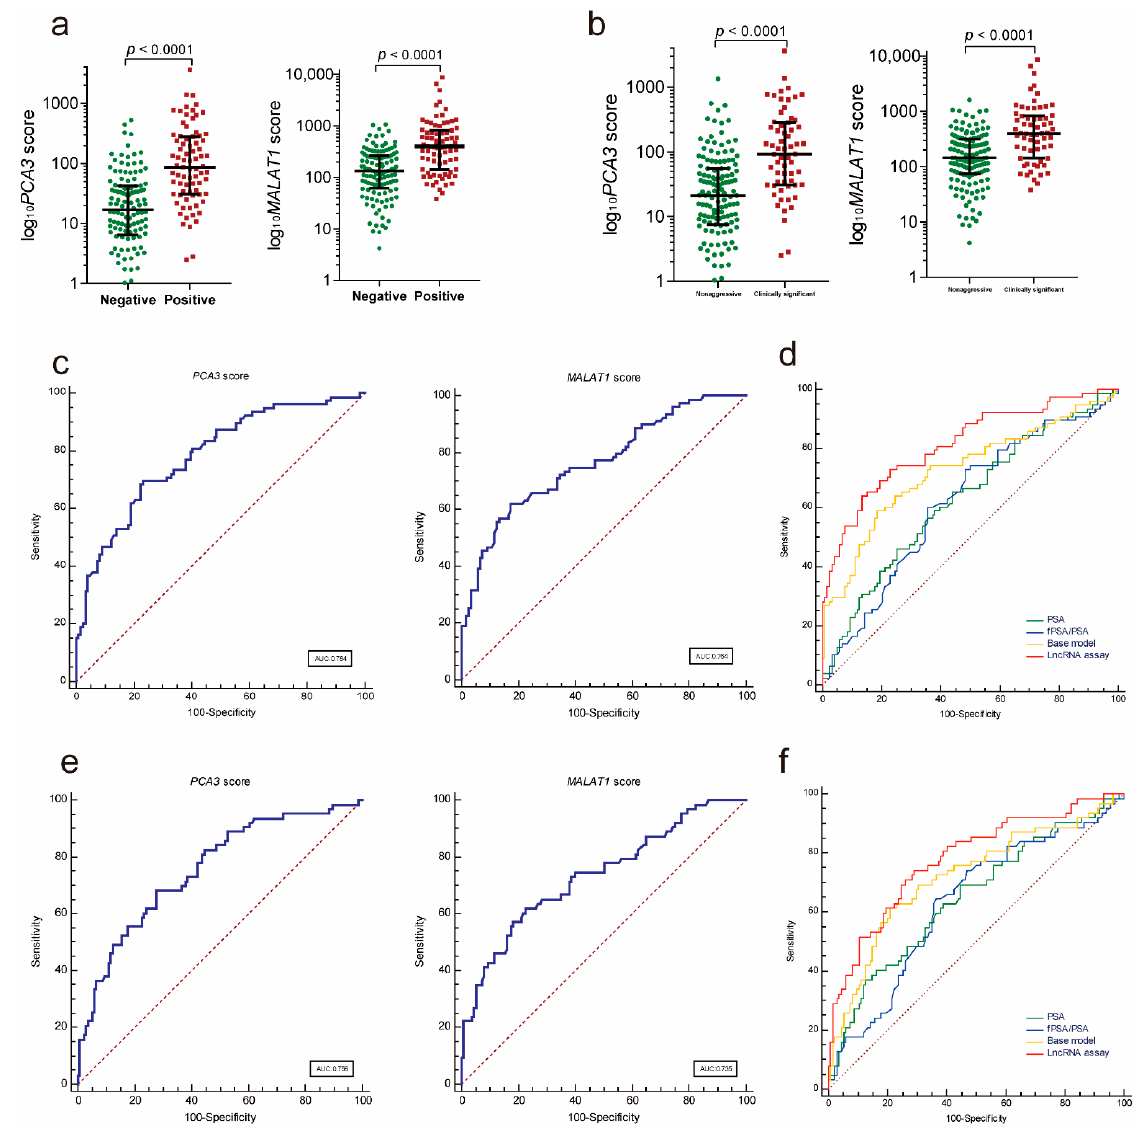
Figure 3. Diagnostic performance of the lncRNA assay in the validation cohort. ( a ) Urinary exosomal PCA3 and MALAT1 were significantly increased in the PCa patients compared to the patients with a negative prostate biopsy (PCA3: p < 0.001; MALAT1: p < 0.001). ( b ) Urinary exosomal PCA3 and MALAT1 were significantly increased in the clinically significant PCa patients compared with the patients with nonaggressive disease (PCA3: p < 0.001; MALAT1: p < 0.001). The ROC analysis shows the diagnostic power of the PCA3 score and the MALAT1 score in diagnosing PCa (( c ), AUC: 0.784 and 0.764, respectively) and clinically significant PCa (( e ), AUC: 0.756 and 0.735, respectively). Comparison ROC analysis shows that the lncRNA assay has a better diagnostic performance than the fPSA/PSA, PSA and the base model in diagnosing PCa (( d ), AUC: 0.814) and clinically significant PCa (( f ), AUC: 0.779). ROC—receiver operating characteristic; PCA3—prostate cancer antigen 3; MALAT1—metastasis-associated lung adenocarcinoma transcript